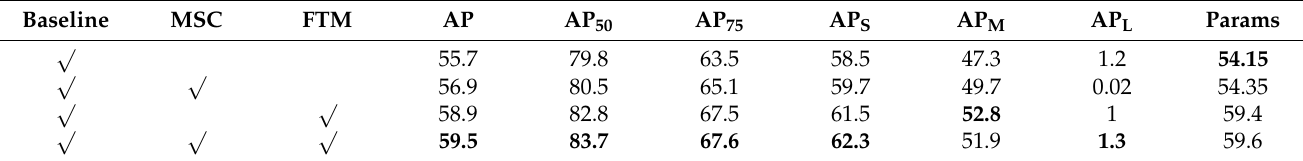
Table 2. Results of ablation experiments.